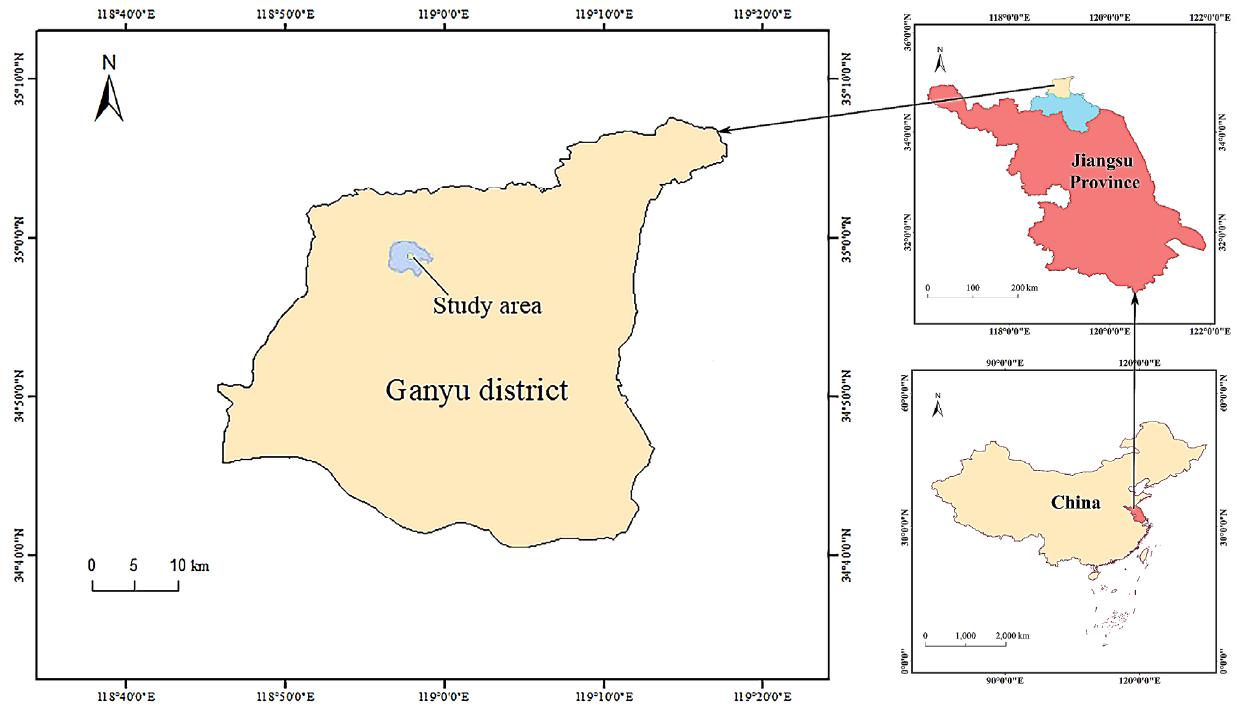
Figure 1. Location of the study site. Table 1. Basic information of the study area.